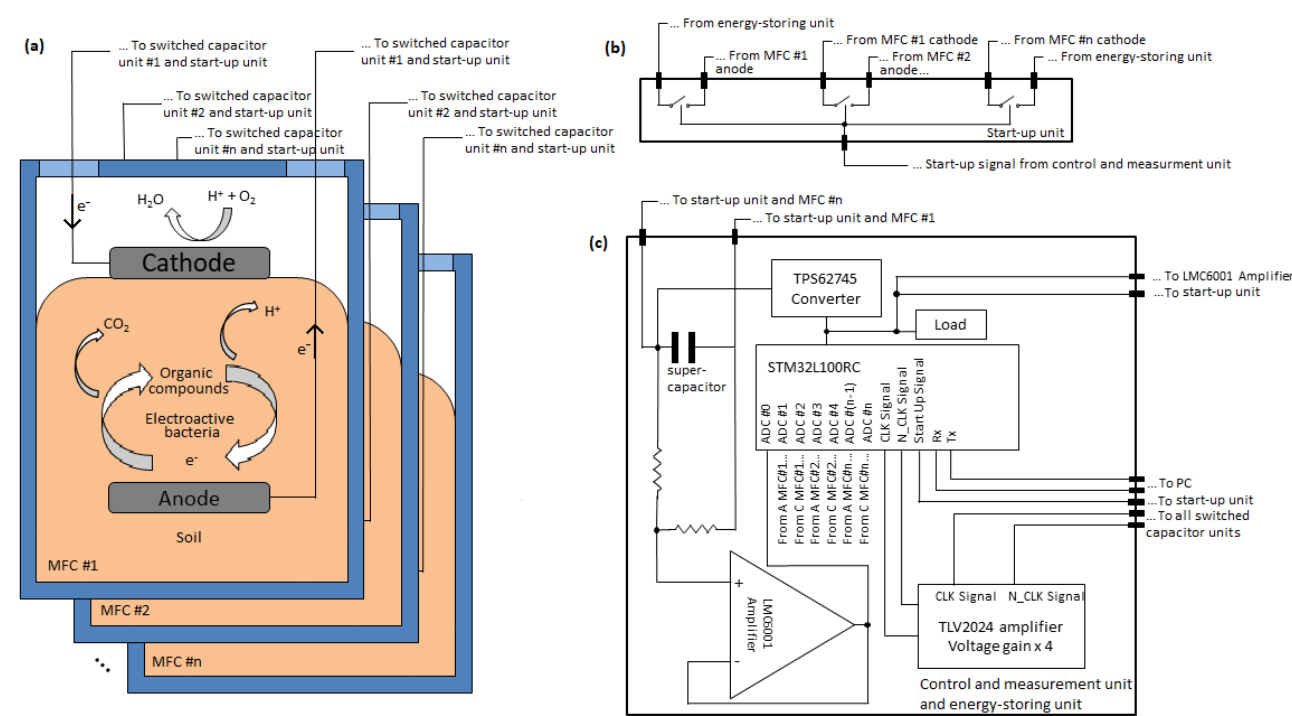
Figure 1. ( a ) MFCs; ( b ) start-up unit; and ( c ) the control and measurement unit and energy-storing unit designed for 7 MFCs.